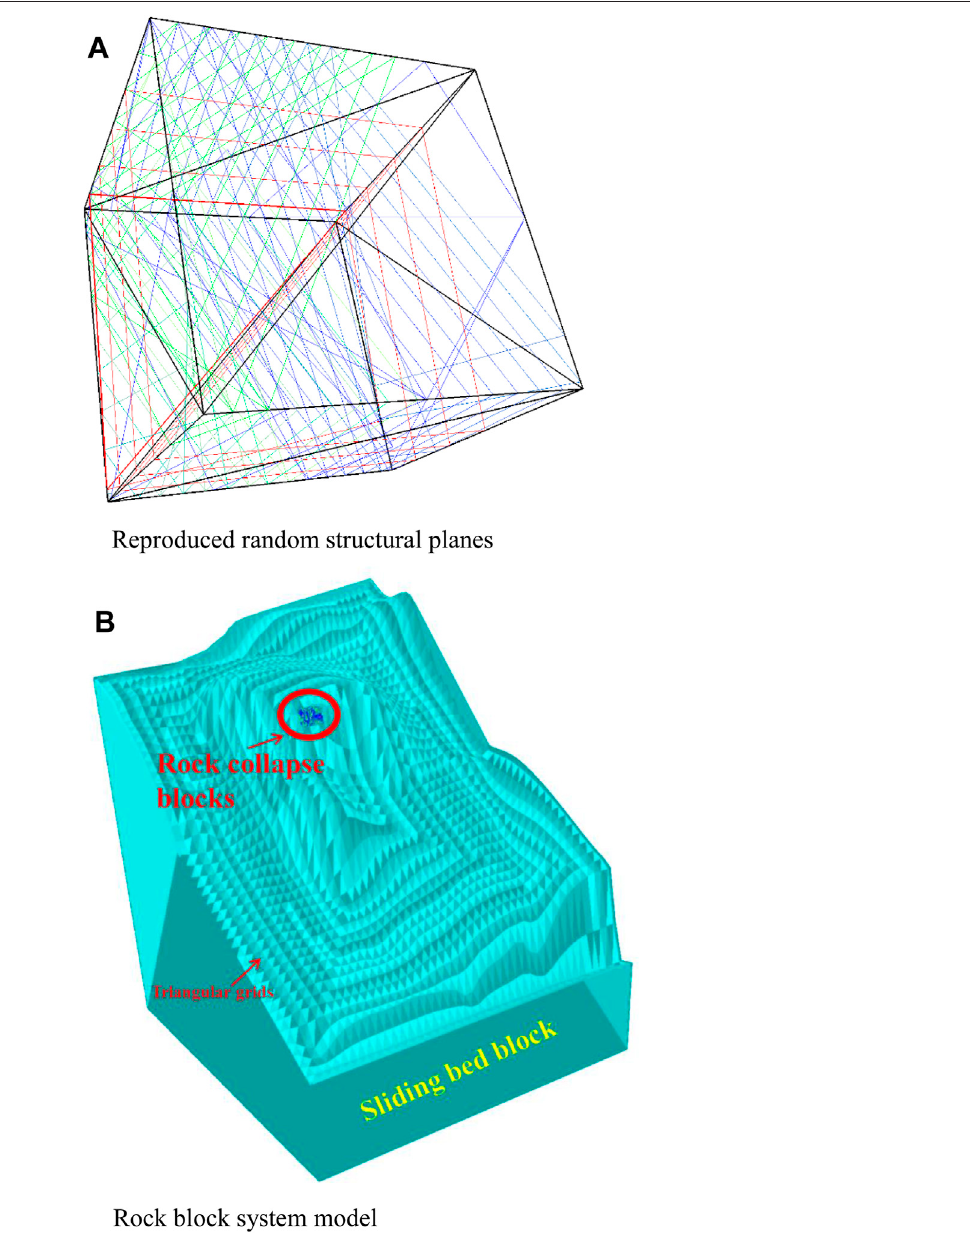
FIGURE 9 | (A) Reproduced random structural planes. (B) Rock block system model rock block system model of a rock collapse.